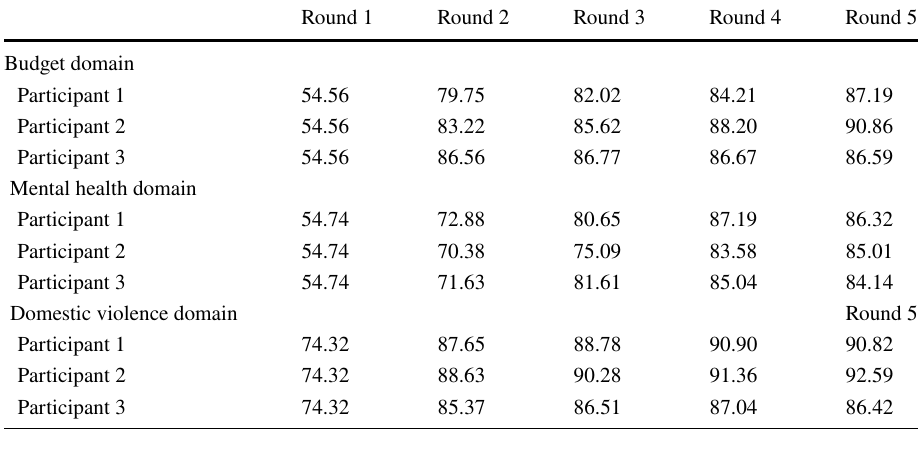
Fig. 9 Number of items anno- tated with rules adapted through participants after five rounds of annotations in three differ- ent curation domains: budget, mental health, and domestic